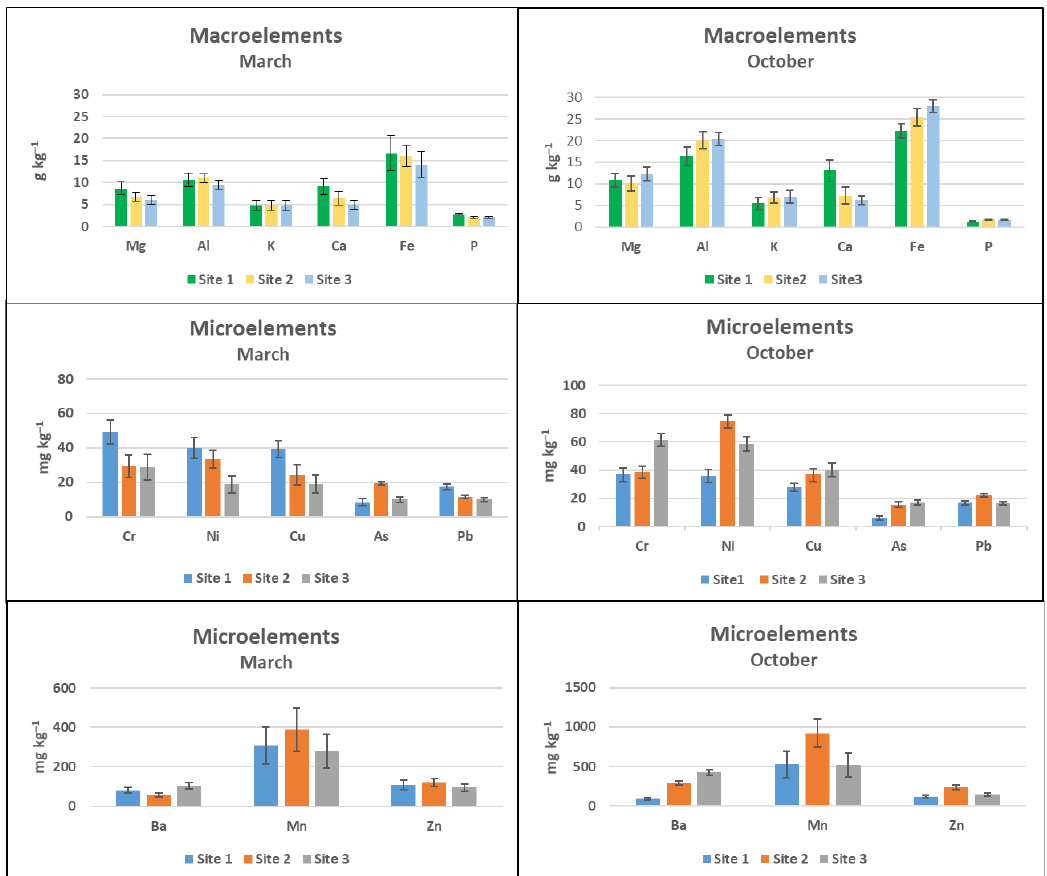
Figure 5. ICP-MS macroelements and microelements in the biofilm. Site 1 (Villadossola), Site 2 (Bosco Tenso), Site 3 (Ornavasso). Data reported on dry weight.